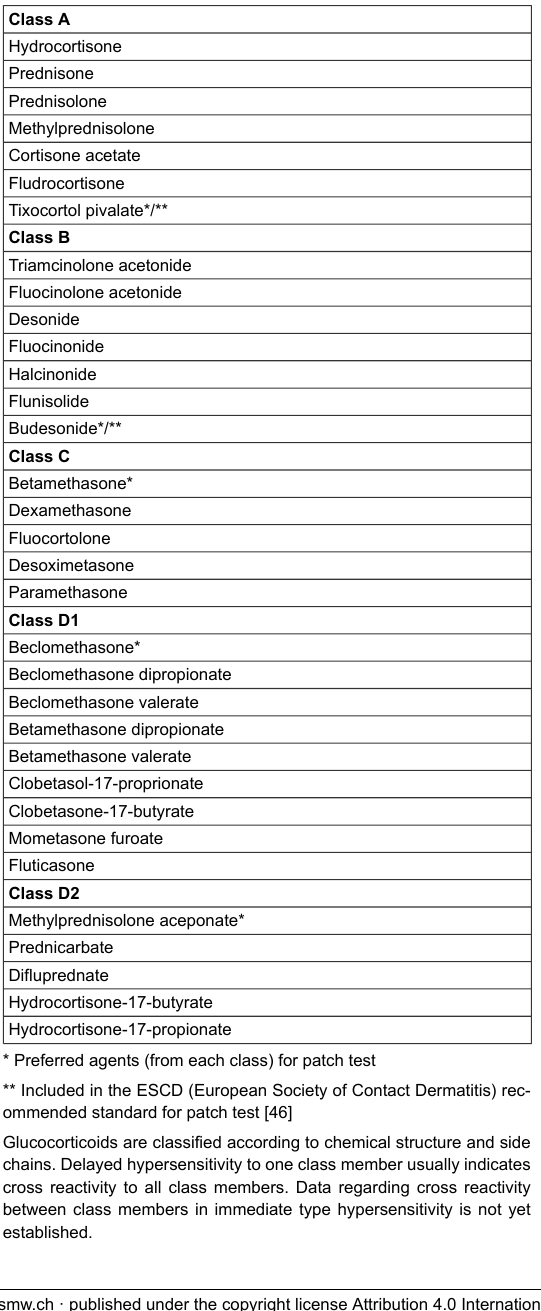
Table 1: Classes of corticosteroid medications [4, 5, 8, 9].